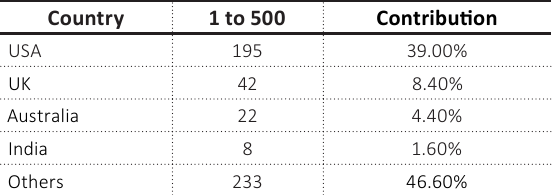
Table 1. Country-wise contribution of the world’s